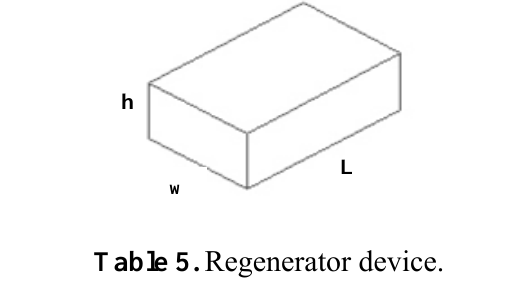
Figure 6. Regenerator; L = 340 mm, w = 215 mm, h = 120 mm.